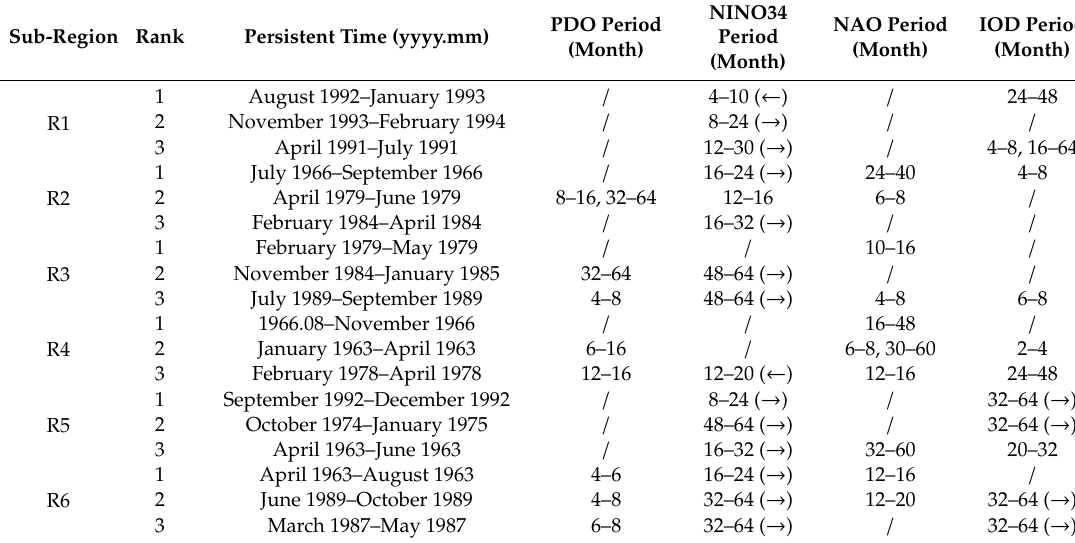
Table 6. The significant link with climate indices for the three most severe drought events in the six sub-regions. Sub-Region